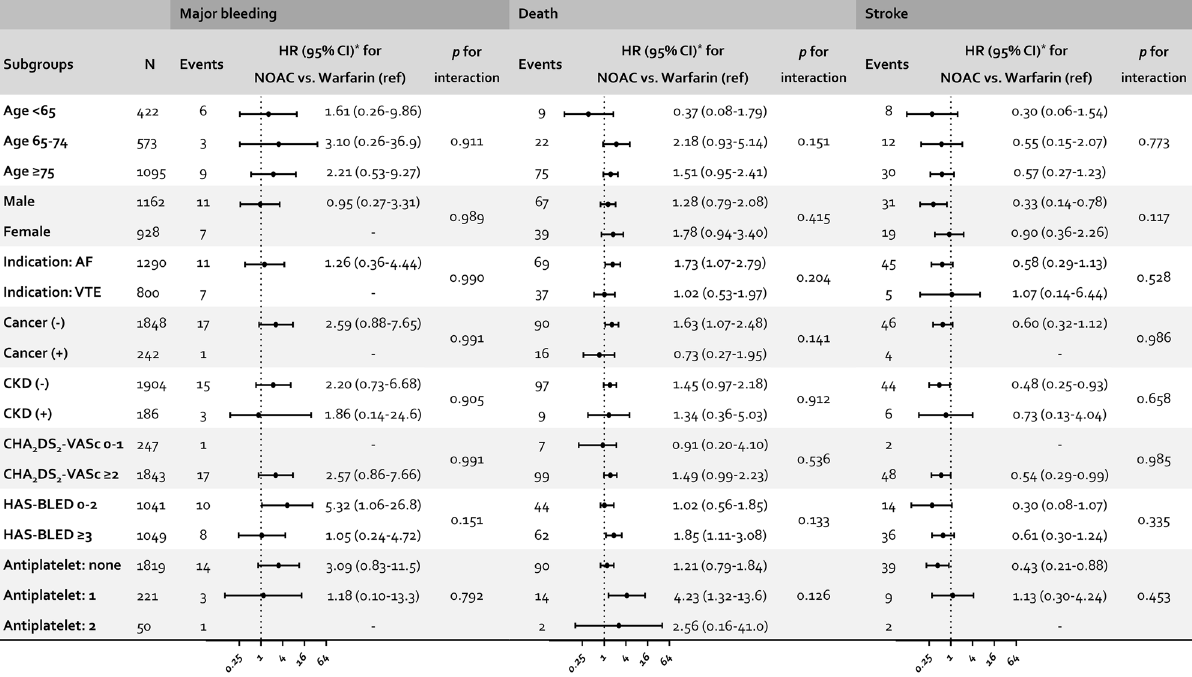
Figure 3. Subgroup analyses of risk for outcomes in warfarin and NOAC users. Adjusted for age, sex, CHA 2 DS 2 -VASc score, history of intracranial hemorrhage, history of gastrointestinal bleeding, chronic kidney disease, cancer, and concurrent antiplatelet usage. HR hazard ratio, NOAC non-vitamin K antagonist